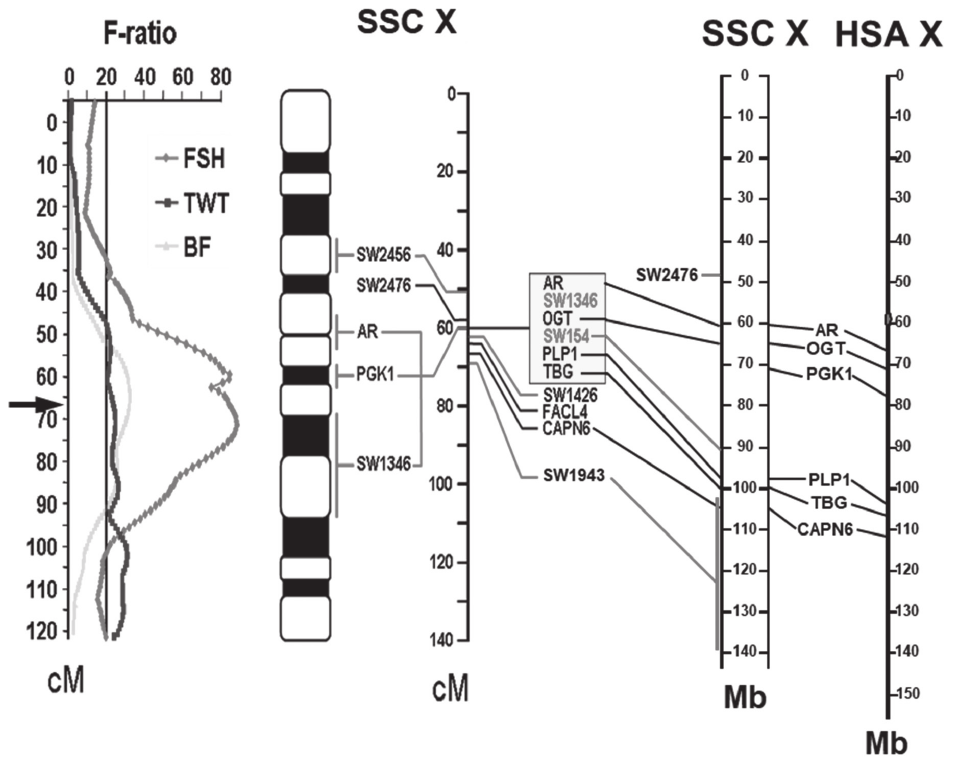
Figure 4. Localization of O-linked N-acetylglucosamine transferase (OGT) on porcine X chromosome. Using the length polymorphism identified in the intron 20 of the OGT gene, OGT was mapped to 67 cM marked by an arrow ( → ) on the porcine chromosome X within the quantitative trait locus (QTL) for follicle stimulating hormone (FSH), testes weight (TWT), and backfat depth (BF). OGT is located between SW1346 and SW154, which is about 65 Mb on the physical map of SSC X. AR and PGK1 are located near the OGT, and PLP1, TBG, and CAPN6 are located around 100 Mb on SSC X. The corresponding genes are shown on HSA X. Gray lines are pig-specific sequences and black lines indicate human- pig homologues. The gray oval at 60 Mb on HSA X is the centromere. SSC, Sus scrofa chromosome, AR, androgen receptor, PGK1, phosphoglycerate kinase 1, PLP1, proteolipid protein 1, TBG, thyroxine-binding globulin, CAPN6, calpain